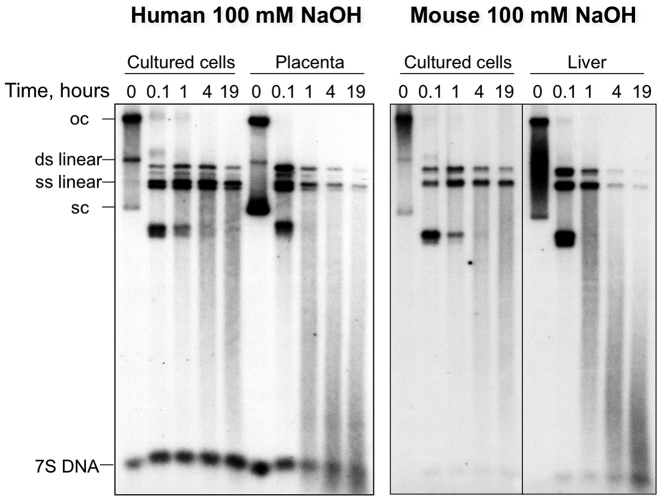
Mammalian mtDNA from solid tissues is more sensitive to alkali than that of proliferating cultured cells. DNA from isolated mitochondria of human 143B cells, human placenta, murine LA9 cells and mouse liver was fractionated by 1D-AGE, after exposure to 100 mM sodium hydroxide (NaOH) for the indicated times, and blot hybridized to radiolabeled probes corresponding to segments of human (16 343–151) or murine (15 007–15 805) mtDNA. oc – open circlular, sc – supercolied, and ds – double stranded, ss – single stranded mtDNA. Treatments with type 2 RNase H fragmented the murine liver mtDNA to a similar extent (Supplementary Figure S1), indicating that most alkali sensitive sites are rNMPs and not abasic sites.